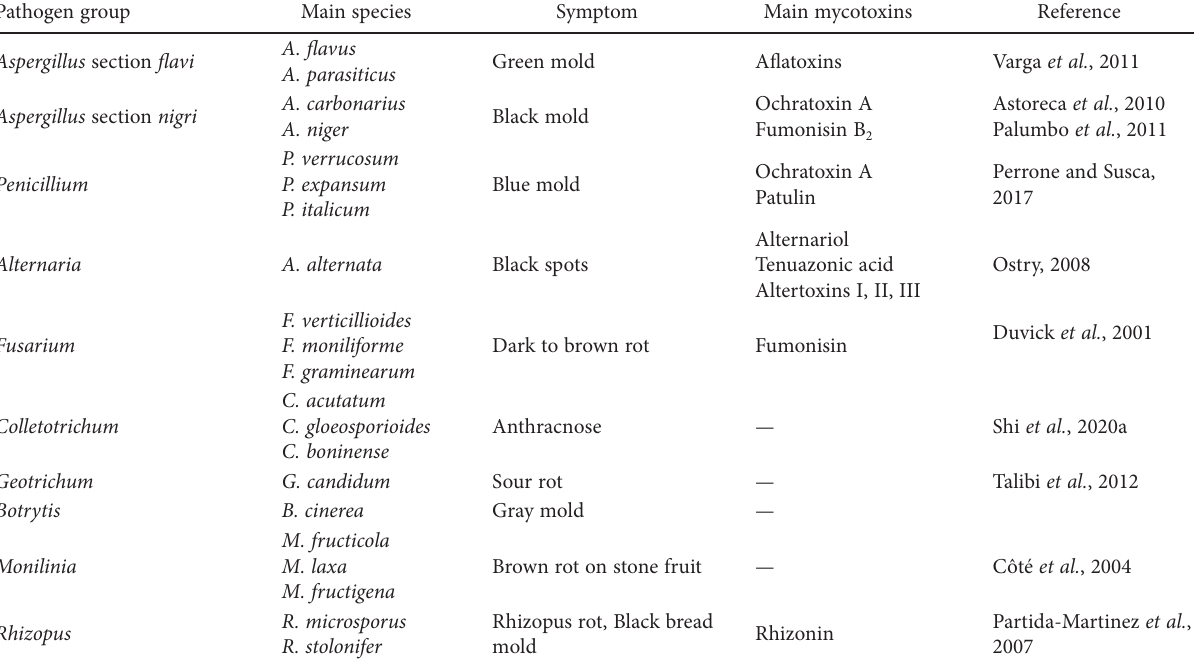
Table 1. The most important postharvest pathogens, the symptoms they cause, and the main mycotoxins they produce. Pathogen group Main